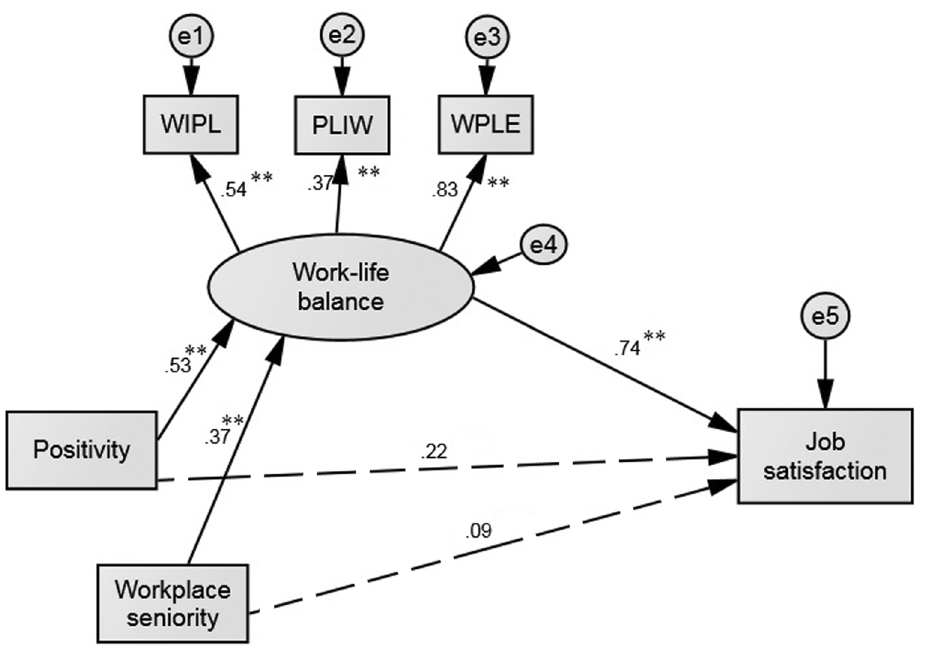
Figure 1. Model depicting the hypothesized mediating role of work-life balance in the relationship between Positivity and Job